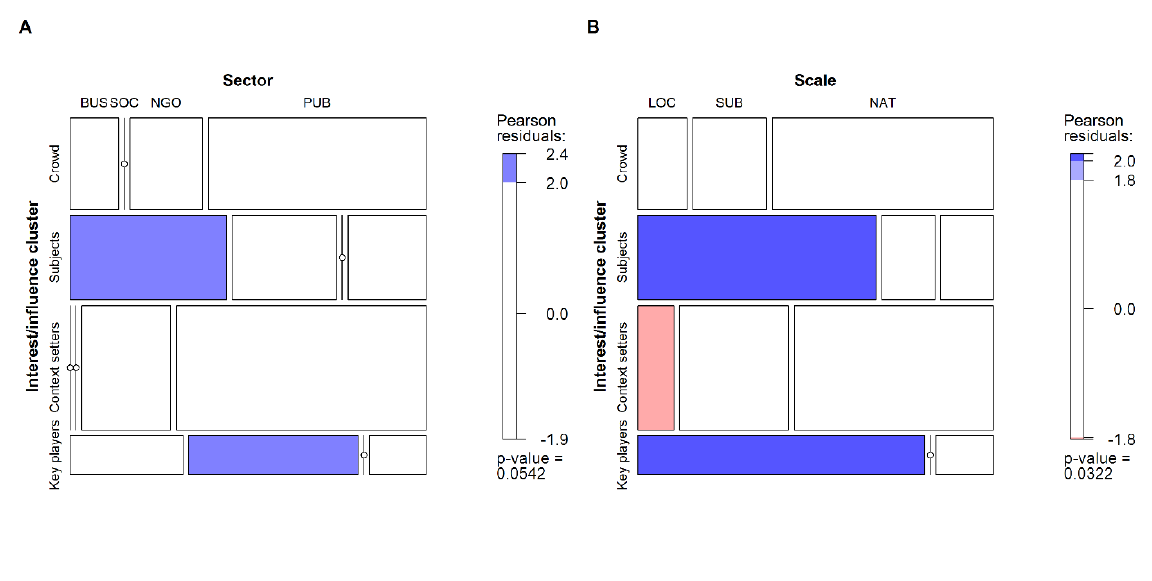
Figure A5.4. Mosaic plots of the frequency of observation of different stakeholder groups into different clusters. Each box is associated with a cluster in left list (Crowd, Subjects, Context setters and Key players) and stakeholders groups in top list (Sector in panel A and Scale of influence in panel B). The height of a box is proportional to the number of stakeholder in each cluster. The width of a box is proportional to the number of stakeholders in each